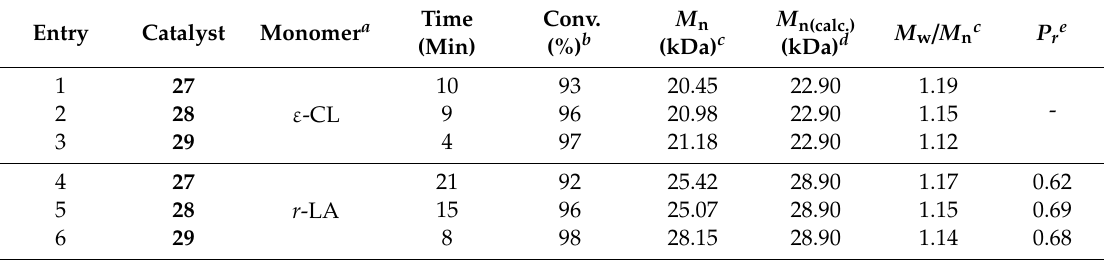
Table 4. ROP of ε -CL and r -LA catalyzed by complexes 27–29 [45].